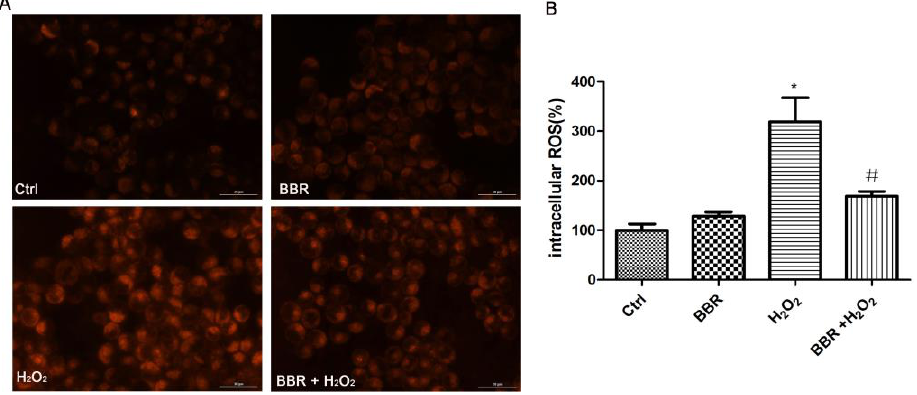
Figure 4. BBR attenuated the H 2 O 2 -induced reactive oxygen species (ROS) production. Exposure of D407 cells to 100 µ M H 2 O 2 resulted in an increase of ROS level. Pre-treatment of cells with BBR at 3 µ M inhibited the H 2 O 2 -induced increase of ROS level in D407 cells. After pre-treatment with 3 µ M BBR or 0.1% DMSO (vehicle control) for 2 h, D407 cells were incubated with or without 100 µ M H 2 O 2 for another 24 h. * indicates p < 0.05 versus the control group were considered statistically different. # indicates p < 0.05 versus the H 2 O 2 -treated group were considered statistically different.